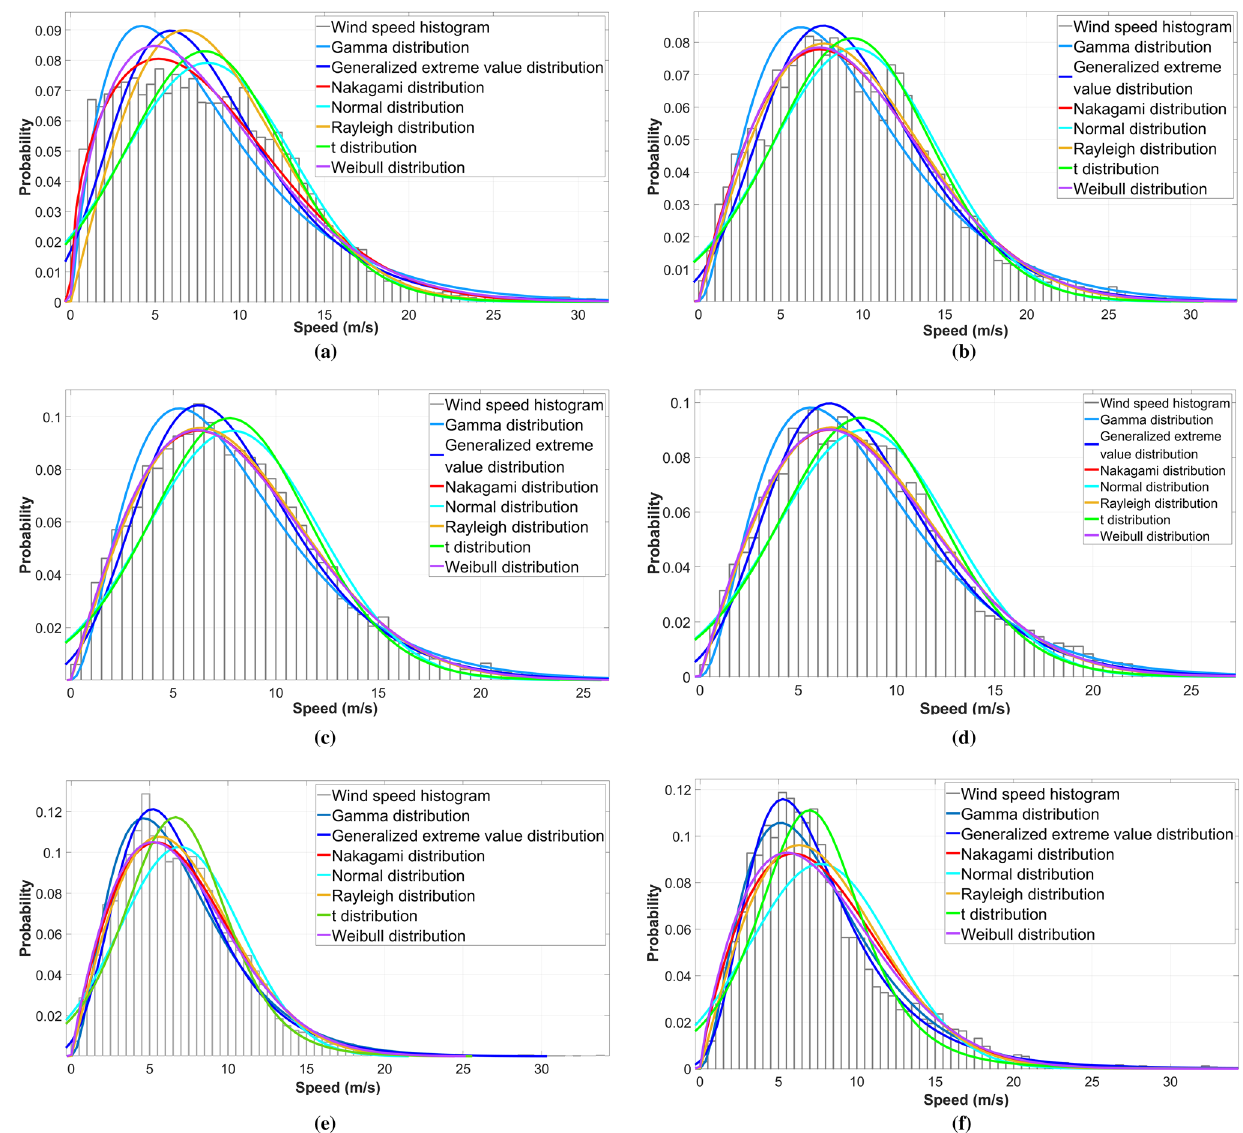
Figure 1. The estimated PDFs curve graphs for NWP model data of five sites and measurements from Fakken wind park (NWP: ( a ) Nygårdsfjellet, ( b ) Raggovidda, ( c ) Kjøllefjord, ( d ) Havøygavlen, ( e ) Fakken, Measurements: ( f ) Fakken).